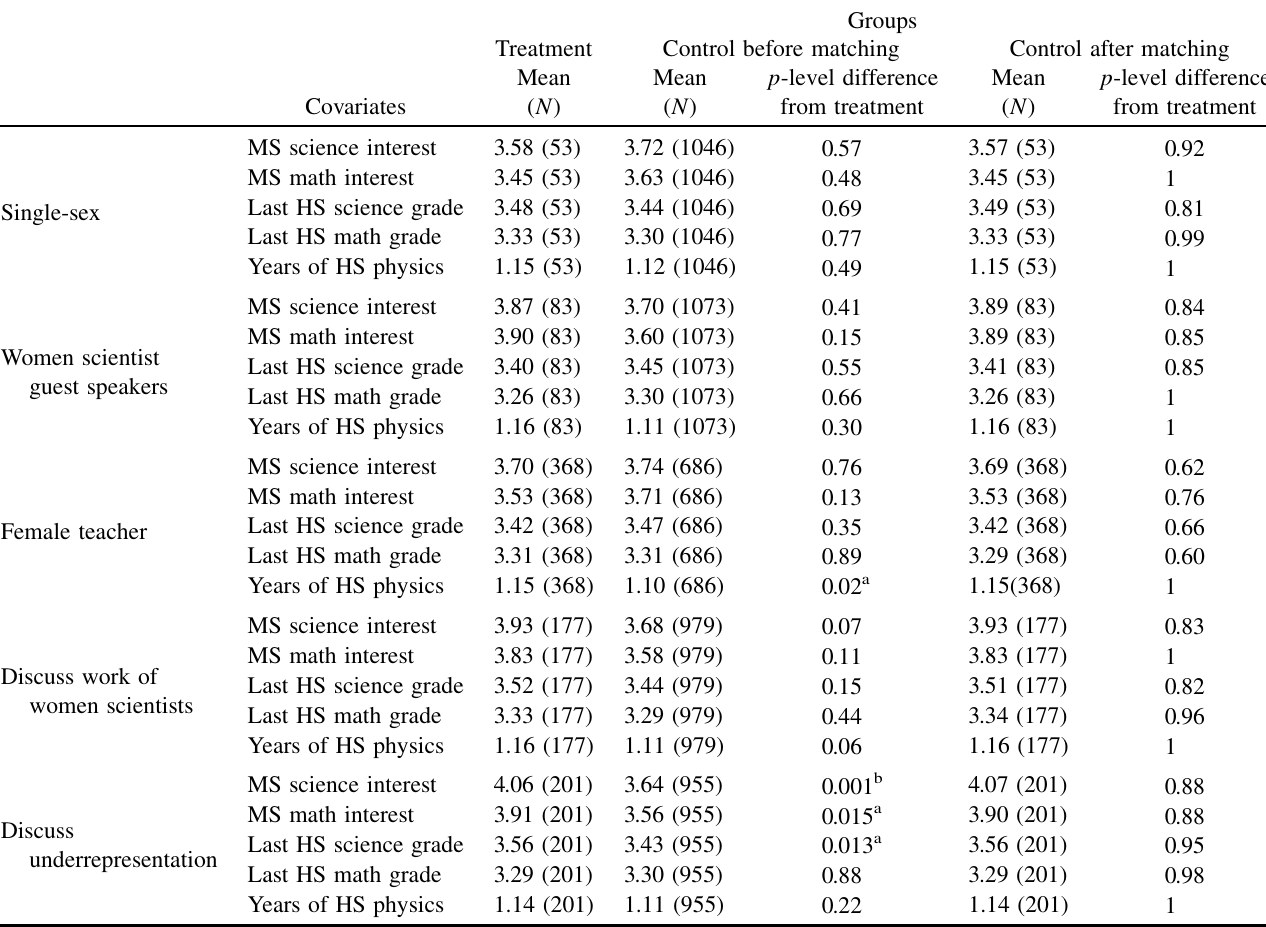
TABLE I. Covariate means before and after matching for each of the five conditions. (MS, middle school; HS, high school.)